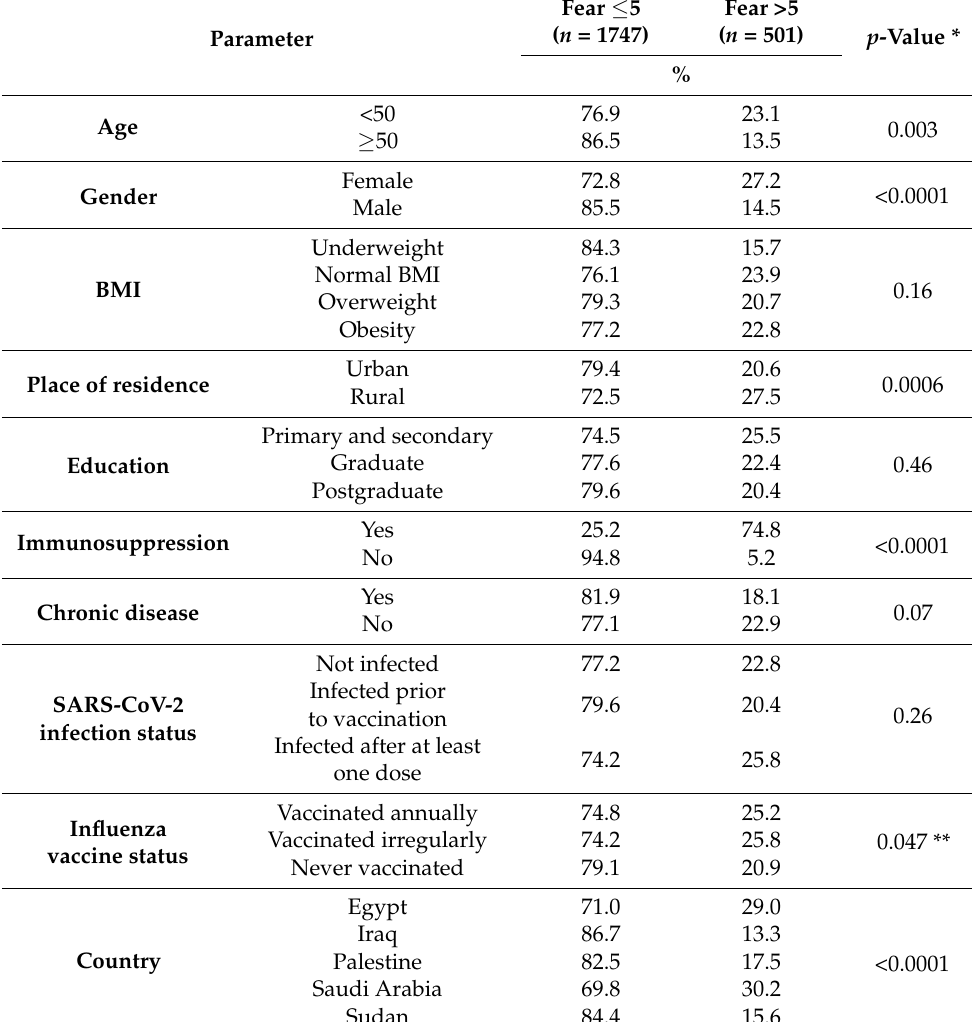
Table 3. The occurrence of fear levels in several demographic groups ( n =